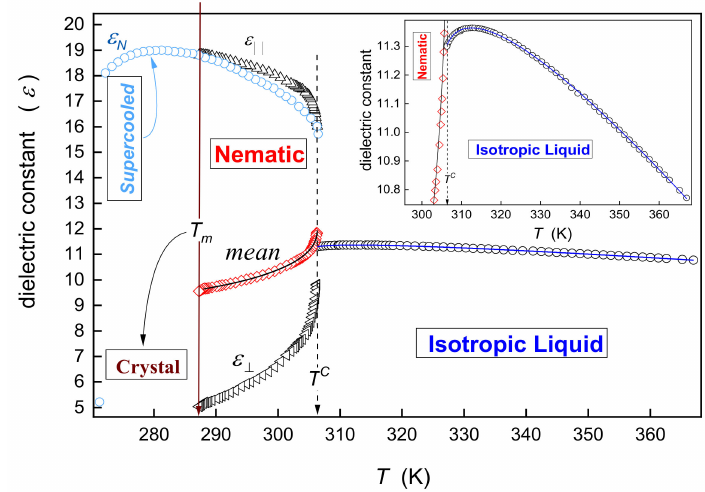
Figure 1. The temperature evolution of dielectric constant ( ε = ε (cid:48) ( f = 10 kHz ) ) in the isotropic liquid and nematic mesophases of pentylcyanobiphenyl (5CB). In the nematic phase, components related to the long ( ε || ) and short-axis ( ε ⊥ ) of the rod-like molecule are shown. The evolution of the mean dielectric permittivity in the nematic phase is calculated via the relation ε mean = ( 1/3 ) ε || + ( 2/3 ) ε ⊥ [1–3]. Pretransitional anomalies in the isotropic liquid and for the mean in the nematic region are described by Equations (6)–(8). The inset shows the ‘focused’ pretransitional e ff ect in the isotropic liquid phase. Experimental data in blue are for the non-oriented sample: note supercooling well below the melting temperature T m